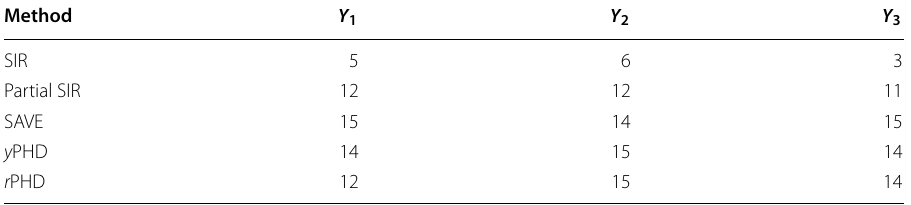
Table 3 Dimensions chosen by the marginal tests for each of the five sufficient dimension reduction